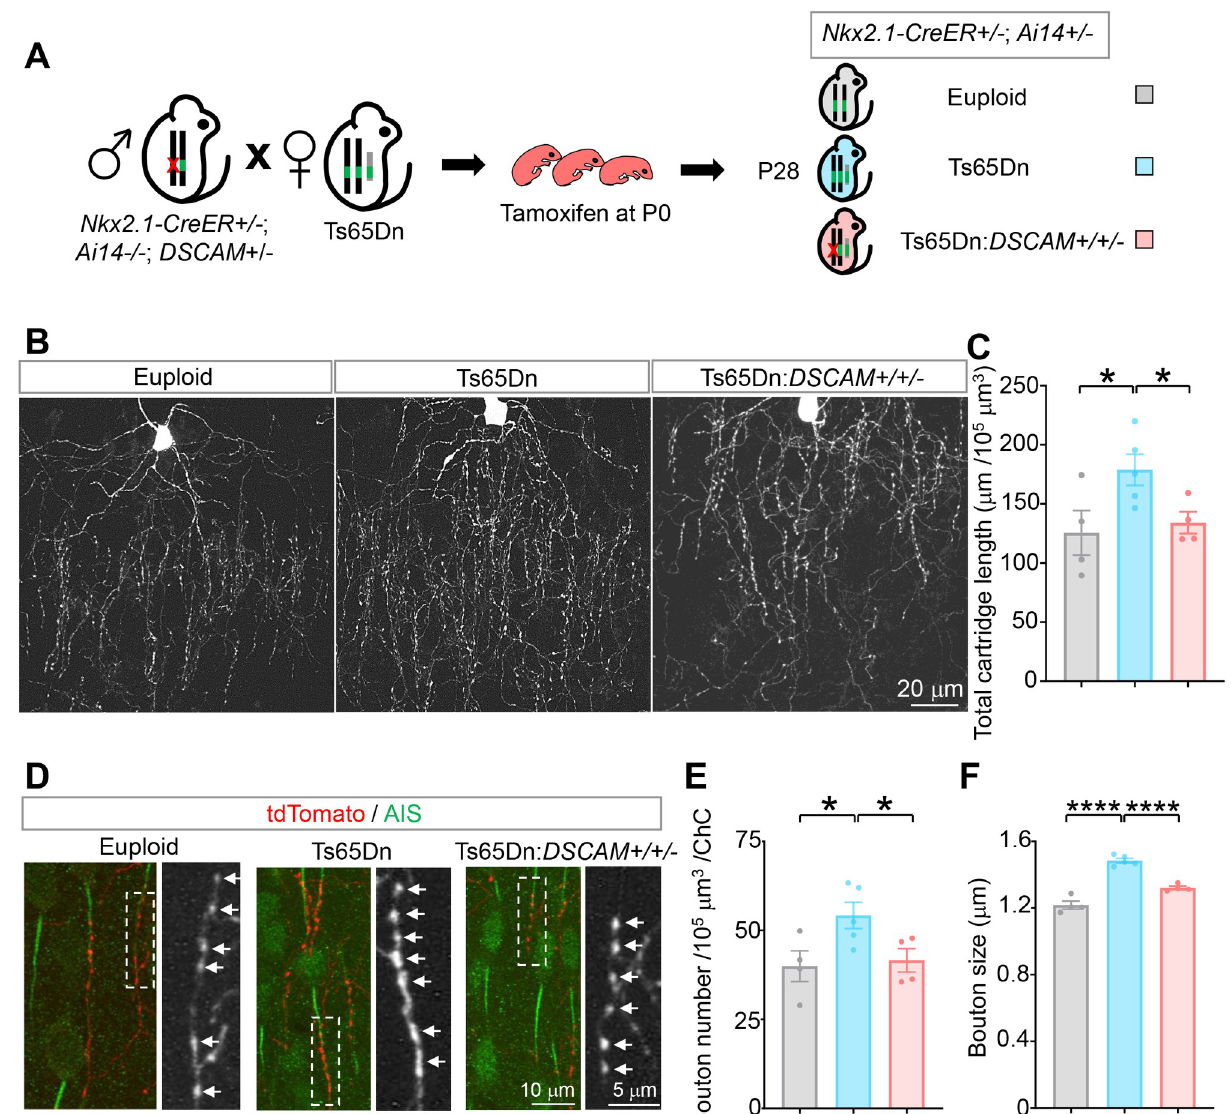
Fig 3. Normalizing DSCAM expression rescues the overgrowth of ChC axon cartridges and presynaptic boutons in Ts65Dn mice. ( A ) A schematic of the procedure that produced the mice for the experiments. ( B ) Representative images of single ChCs in layer II/III of the ACC. Shown are ChCs of euploid, Ts65Dn, and Ts65Dn with DSCAM allele normalized (Ts65Dn: DSCAM+/+/− ) mice at P28. Scale bar, 20 μ m. ( C ) Quantification of the total cartridge length. For each ChC, all axon cartridges (approximately 15–40) innervating the AIS of PyNs in a volume of 120 μ m (length) × 80 μ m (width) × 30 μ m (thickness) with the ChC cell body in the top middle were analyzed (S6 Fig). For each mouse, 4–6 ChCs were analyzed; 4 euploid, 5 Ts65Dn, and 4 Ts65Dn: DSCAM+/+/− mice were analyzed. ( D ) Representative images of ChC axon cartridges innervating the AIS of PyNs. Cartridges of single ChCs were labeled with tdTomato (Red). The AIS of PyNs were labeled by anti-phospho-I κ B (pI κ B, green). The arrows point to presynaptic boutons of ChCs in the boxed regions. ( E , F ) Quantification of bouton number ( E ) and size ( F ). For each ChC, all boutons in axon cartridges that innervate AIS in the defined volume (S6 Fig) were analyzed for bouton numbers; boutons in the 10 cartridges nearest to the cell body were analyzed for bouton sizes. For each mouse, 4–6 ChCs were analyzed, and 4 euploid, 5 Ts65Dn, and 4 Ts65Dn: DSCAM+/+/− mice were analyzed. Each dot in the charts represent 1 mouse. One-way ANOVA for multigroup comparisons and post hoc Student t tests for pair-wise comparisons. * : p < 0.05; **** : p < 0.0001. The data underlying this Figure can be found in https://doi.org/10.5281/zenodo.7714234. ACC, anterior cingulate cortex; AIS, axon initial segment; ChC, chandelier cell; DSCAM, Down syndrome cell adhesion molecule; PyN, pyramidal neuron; P28, postnatal day 28.